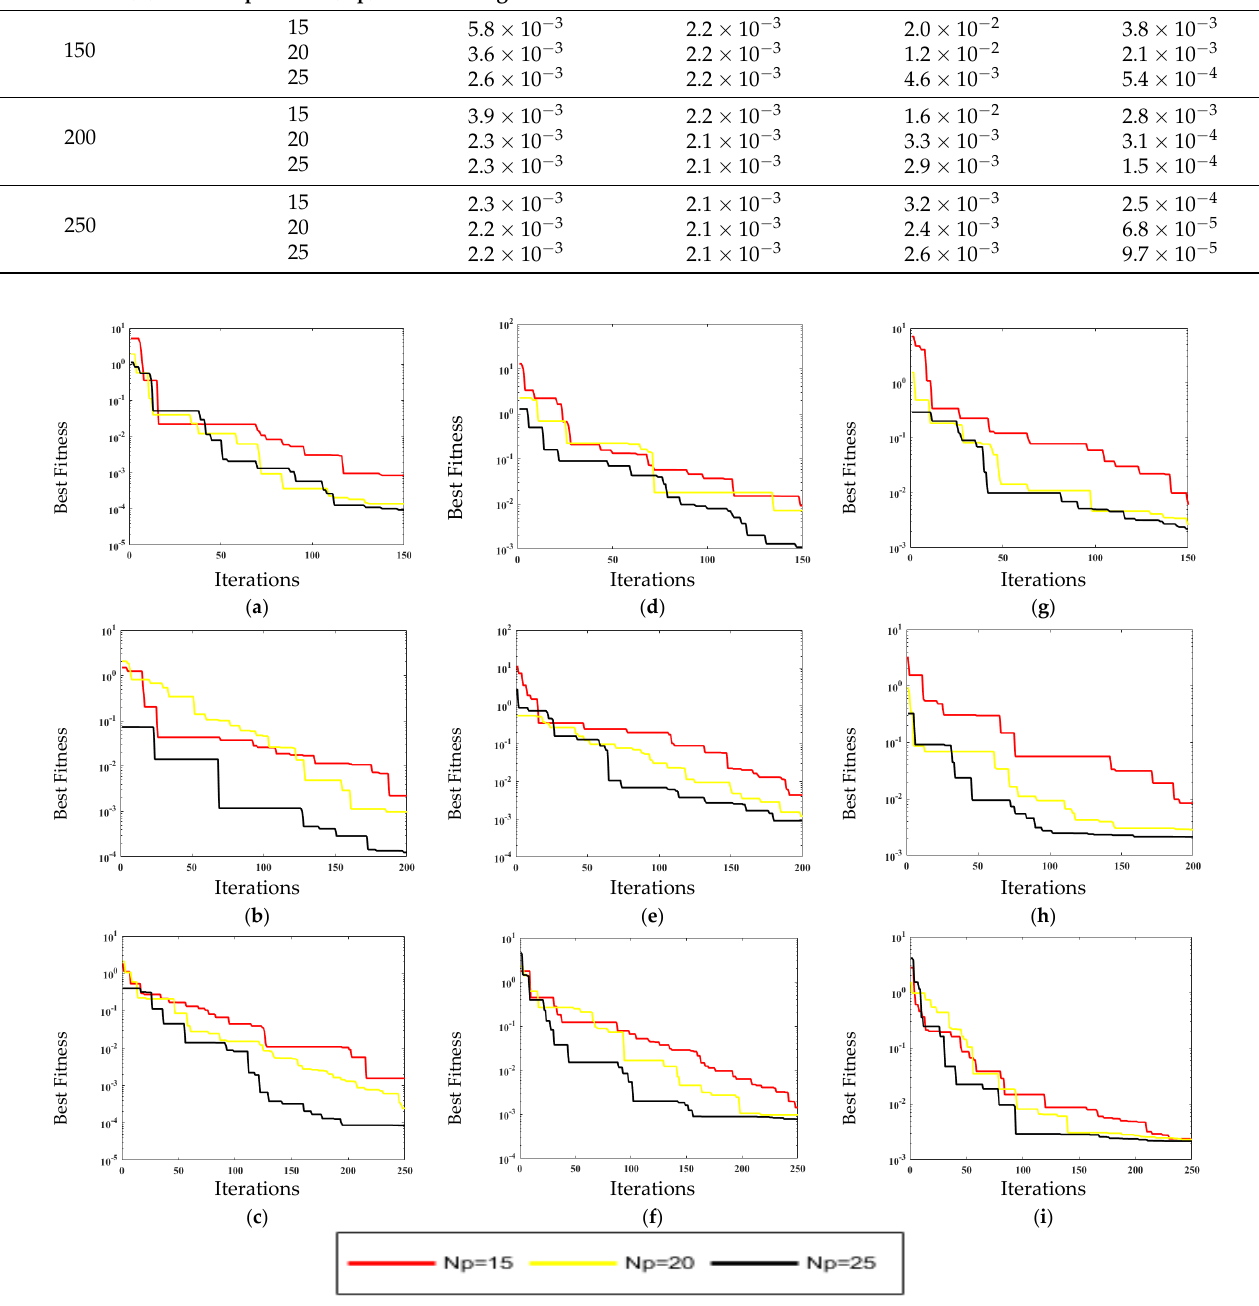
Table 4. DMOA analysis w.r.t. generation numbers and population sizes at 0.05 noise variance.